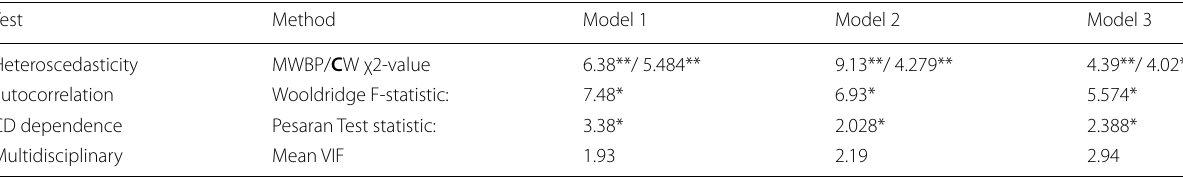
*Indicates Significance level 0.05 and ** Indicates Significance level